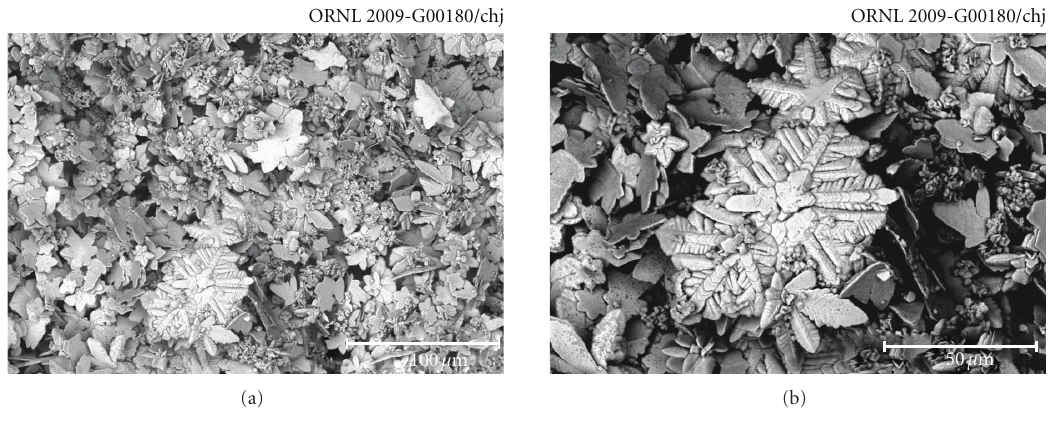
Figure 9: Metallic Zn crystal layer formed at the surface of a ZnO single-crystal photoanode after 17 hours of operation in a photoelectrochemical cell. (a) An overall low magnification view showing the porous nature of the altered surface layer. (b) A detailed view showing the Zn metal dendritic growth morphology.